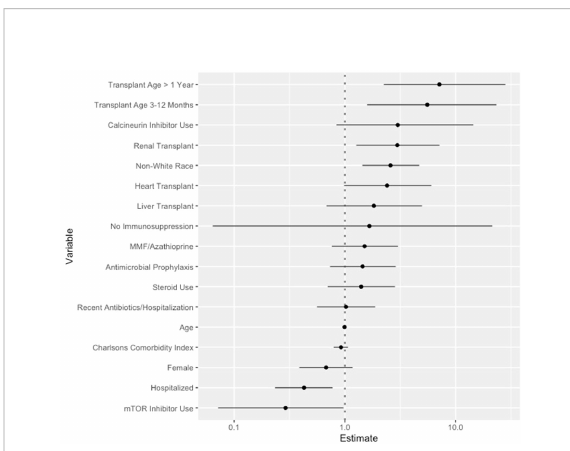
FIGURE 2 Multivariate Analyses of Factors Predictive of Positive GI Panel in Solid Organ Transplant Recipients with Acute Diarrhea. Coef fi cient plot of the multivariate logistic regression predicting positive GI panel with 95% con fi dence intervals demonstrated. Reference groups are as follows for the listed variables: transplant type: lung, transplant age: 0-3